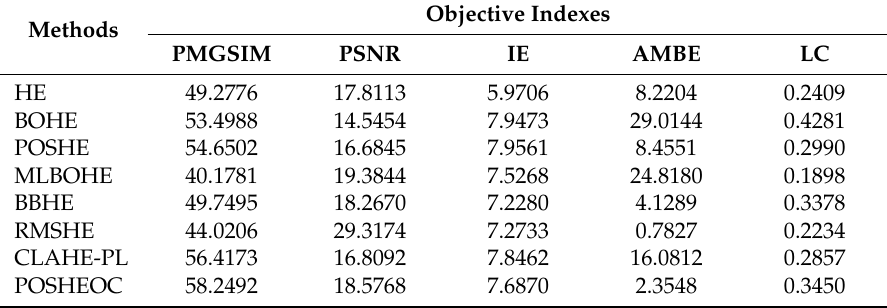
Table 3. Quantitative results for ultrasonic logging image of Changqingli well with various